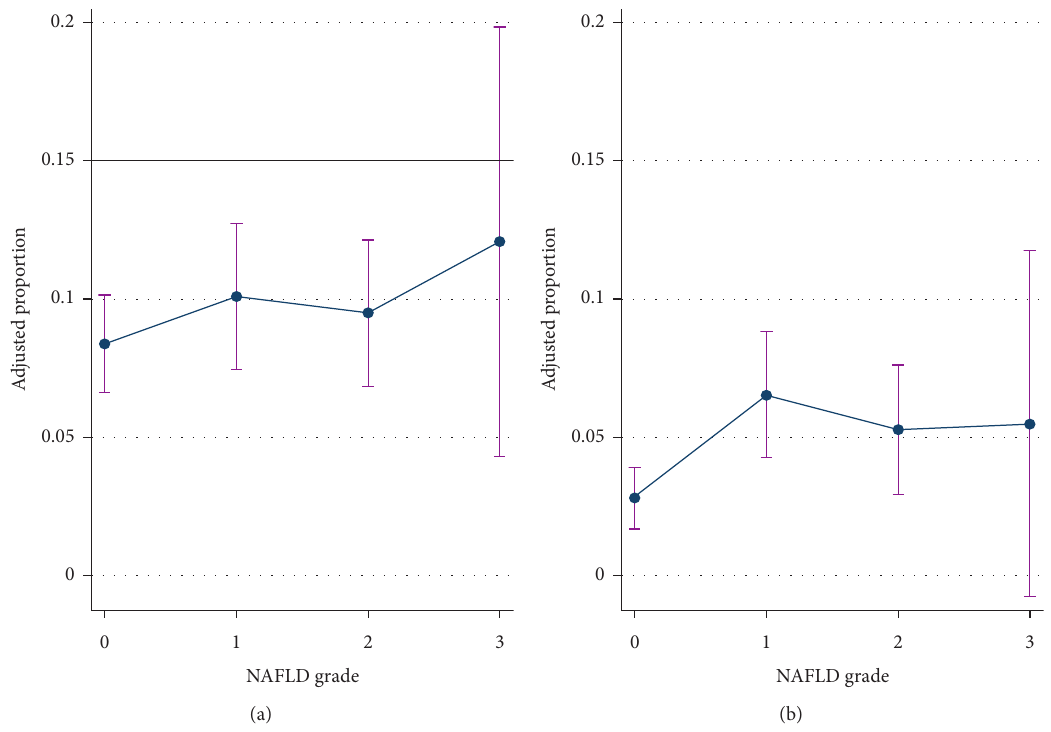
Figure 2: Risk ratio and predictive probability (95% CI) by degree of NAFLD in (a) male and (b)